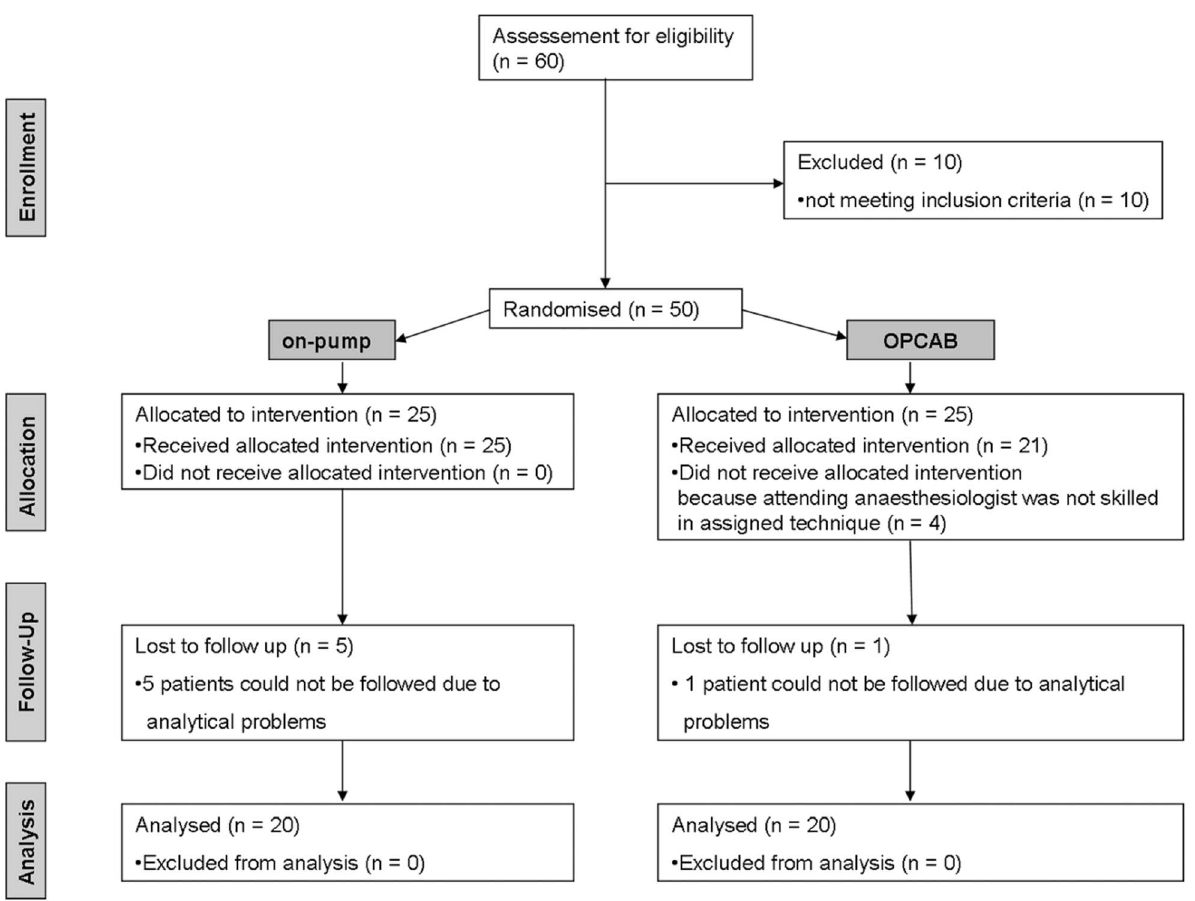
Figure 1. Flowchart. According to the CONSORT-statement for randomised clinical trials. From the initially screened 60 patients, 46 patients received the allocated intervention. 6 patients had to be excluded from further analysis.